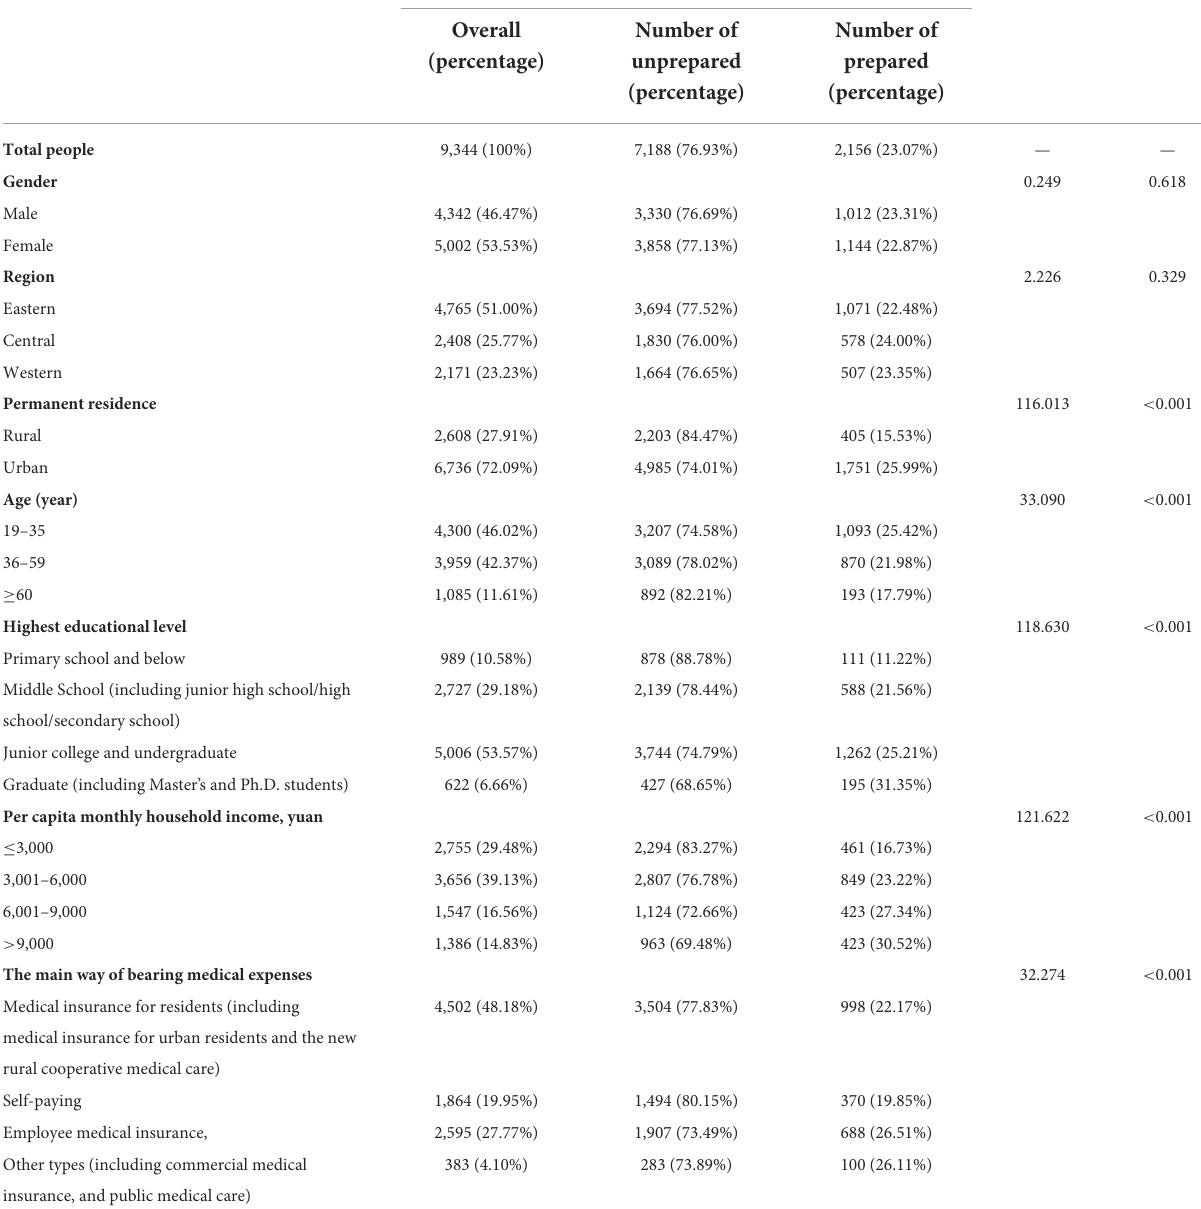
TABLE 1 Basic information of respondents and preparation status of home first-aid